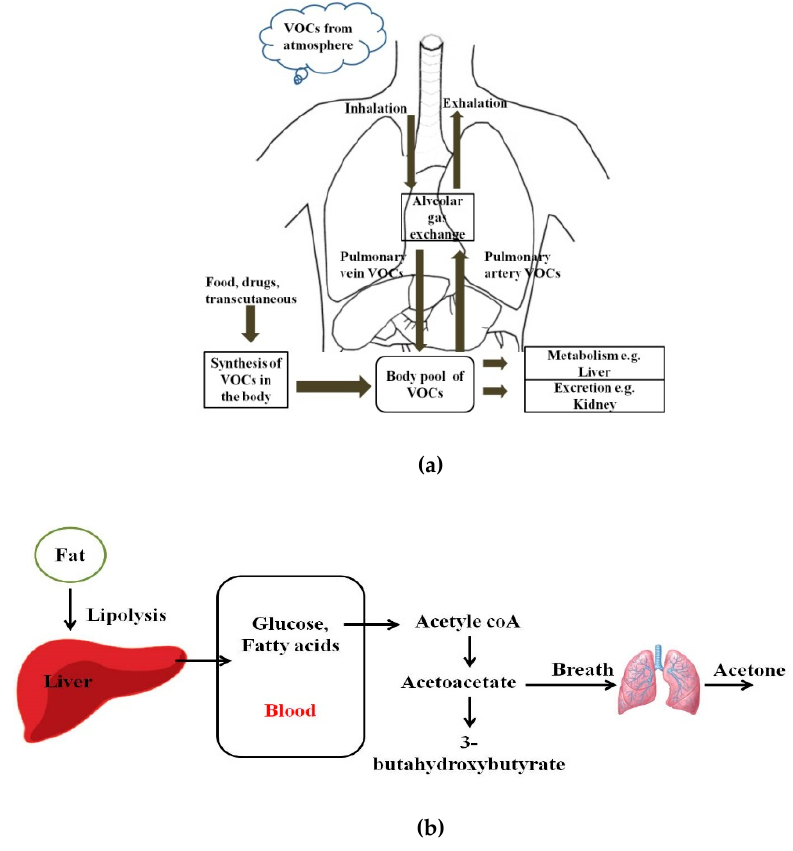
Figure 1. ( a ) Pathways for volatile organic compounds (VOCs) in the human body; ( b ) Schematic diagram of the formation of acetoacetate, beta-hydroxybutyrate, and acetone, which takes place in the mitochondrial matrix of the liver.